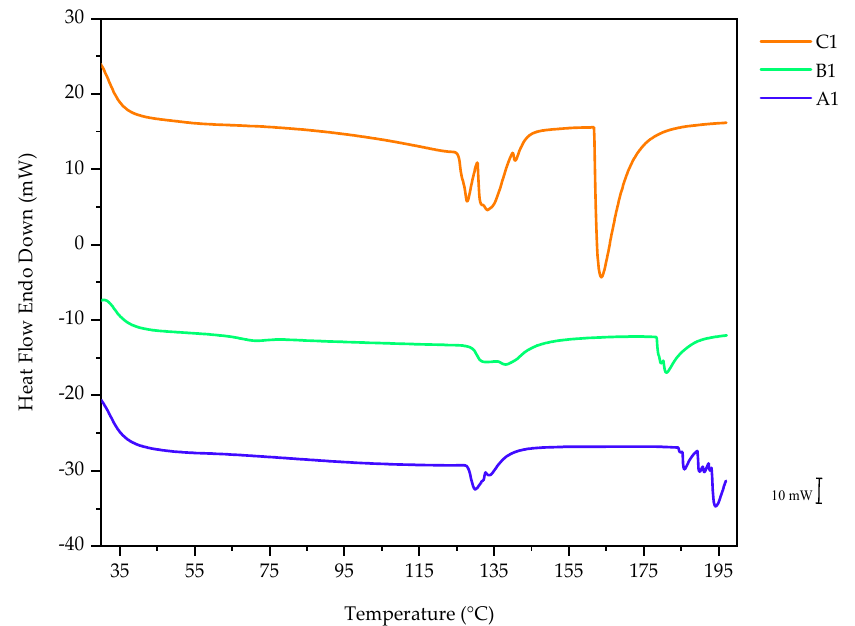
Figure 5. Representative thermograph displaying an overlay of PNVCL, P(NVCL-VAc10), and P(NVCL-NVP10) polymers.